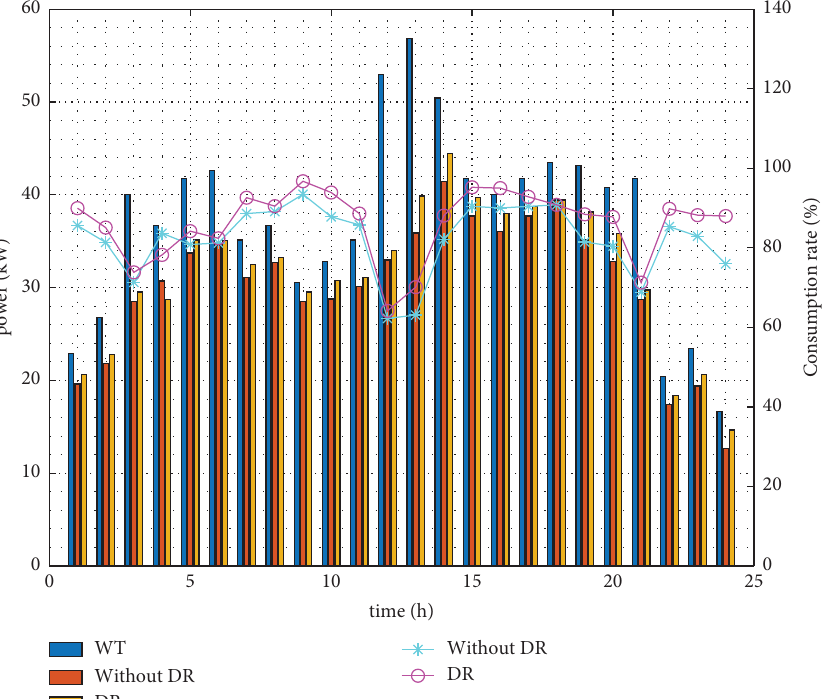
Figure 9: Comparison of wind energy consumption before and after DR.